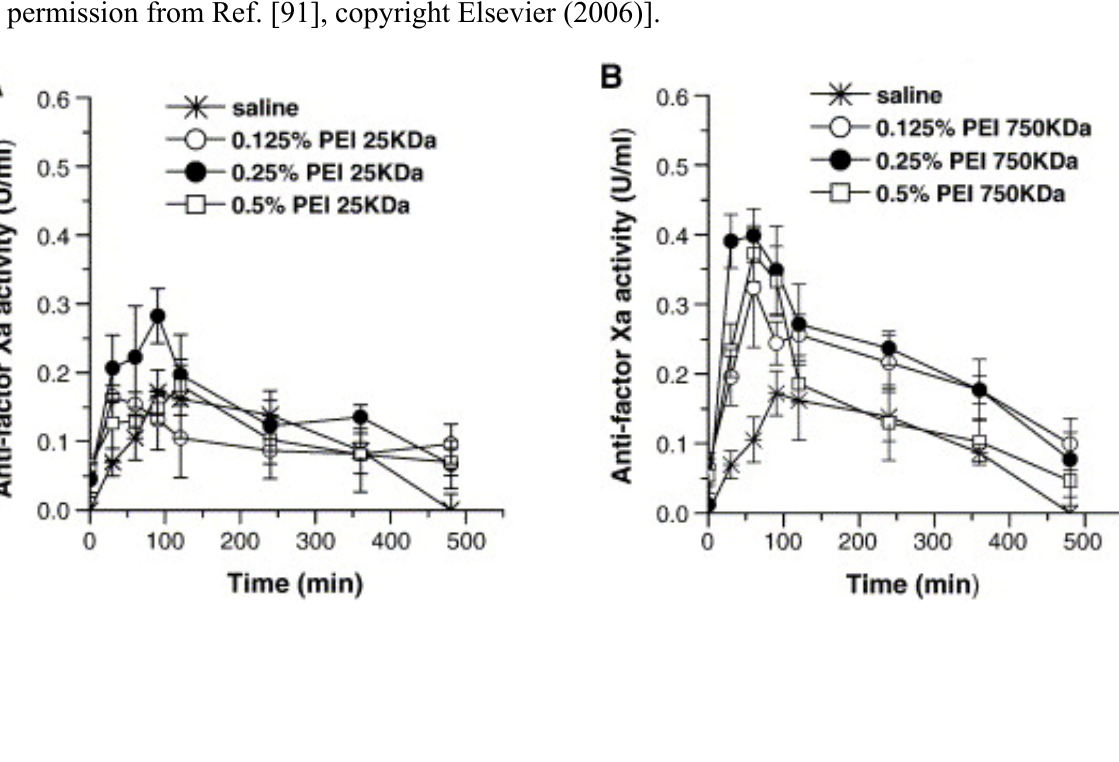
Figure 6. Changes in anti-factor Xa activity after nasal administration of enoxaparin formulated in saline or in the presence of different concentrations of (A) PEI-25 kDa, (B) PEI-750 kDa, or (C) PEI-1000 kDa. Data represent mean ± S.E.M., n = 3–5 [reprinted with permission from Ref. [91], copyright Elsevier